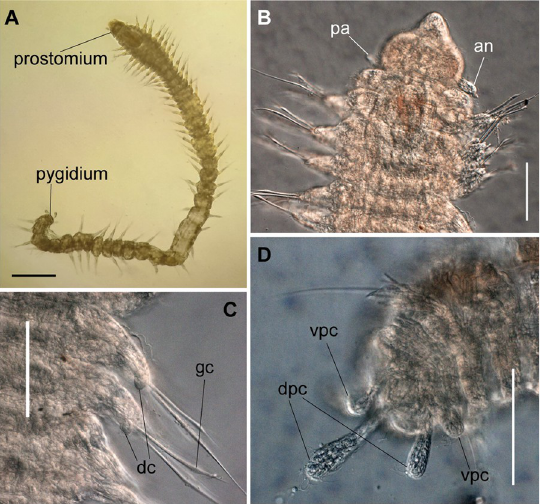
Fig 18. Meiodorvillea jumarsi sp. nov. (A) complete specimen, dorsal view; (B) anterior region, dorsal view; (C) parapodia with dorsal cirri and geniculate chaetae from anterior region, dorsal view; (D) pygidium, ventral view. Abbreviations: an = antenna; dc = dorsal cirrus; dpc = dorsal pygidial cirrus; gc = geniculate chaeta; md = mandible; mp = maxillary plates; pa = palp; vpc = ventral pygidial cirrus. Scale bars: (A) = 200 μ m; (B) = 100 μ m; (C,D) = 88 μ m.